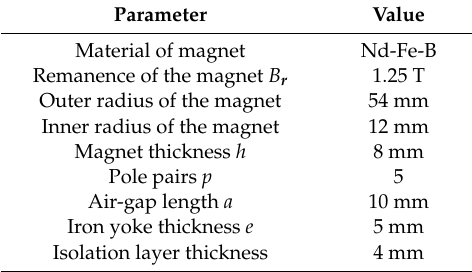
Table 3. The optimal parameters of the axial-flux type magnetic coupling.